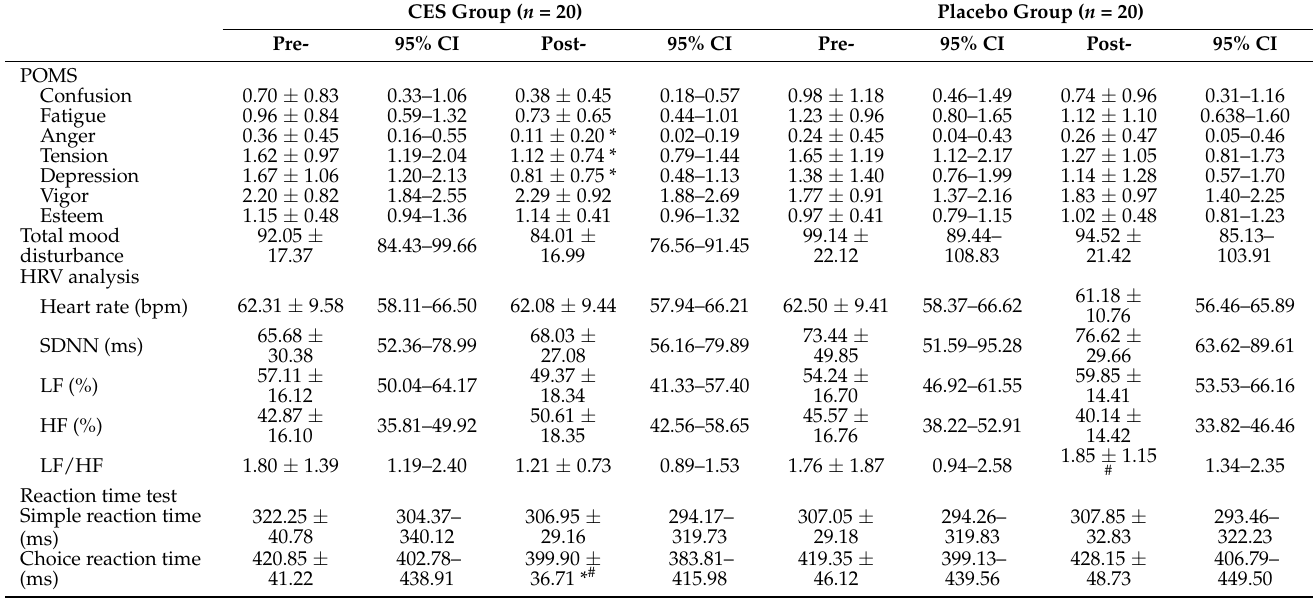
Table 3. Outcomes of POMS, HRV analysis, and reaction time test between